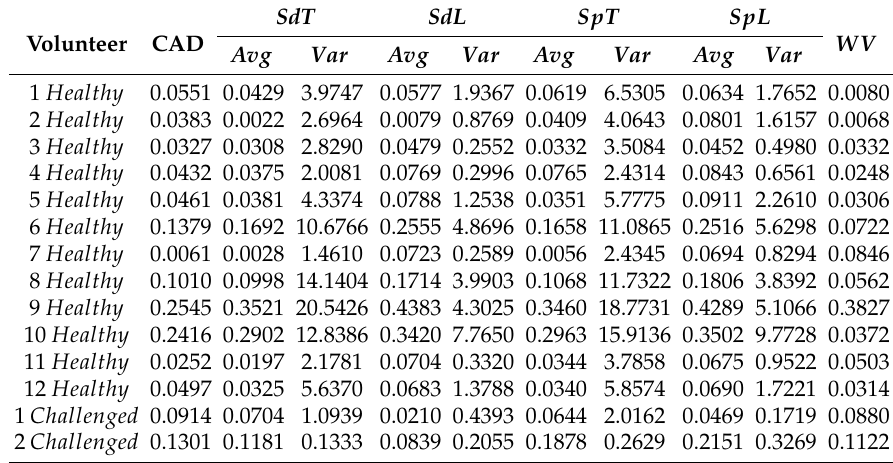
Table 2. Relative error for each gait parameter obtained from the i-Walker with respect to the Optotrak per